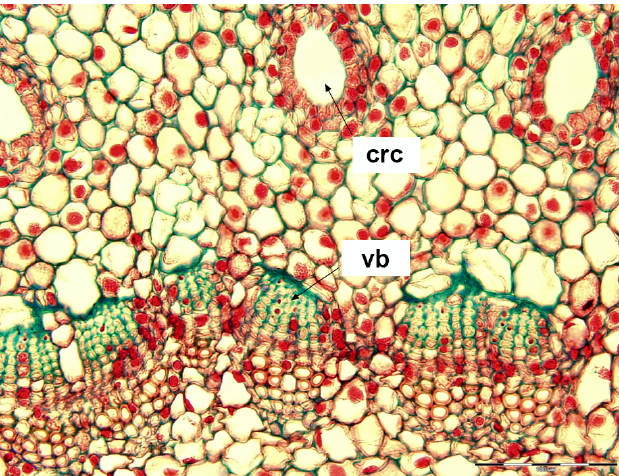
Figure 1 Abies sp. – microscopic view of the shoot’s primary structure in a cross section. In the upper part of the photograph, the discrete cortical resin canals (crc) are visible; in the lower part, tightly packed vascular bundles (vb); their primary phloem cells are stained green. Scale bar: 100 µ